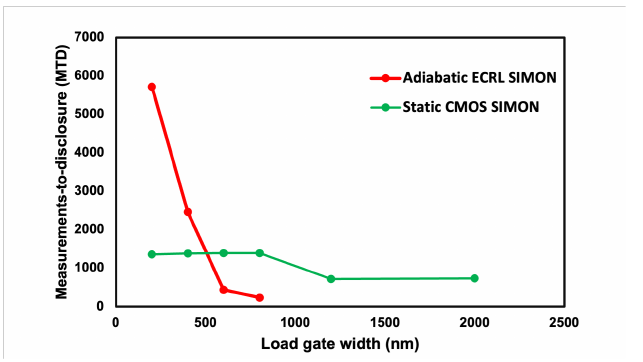
Figure 10. CPA target signal load size vs. MTD for static CMOS based SIMON core and adiabatic SIMON